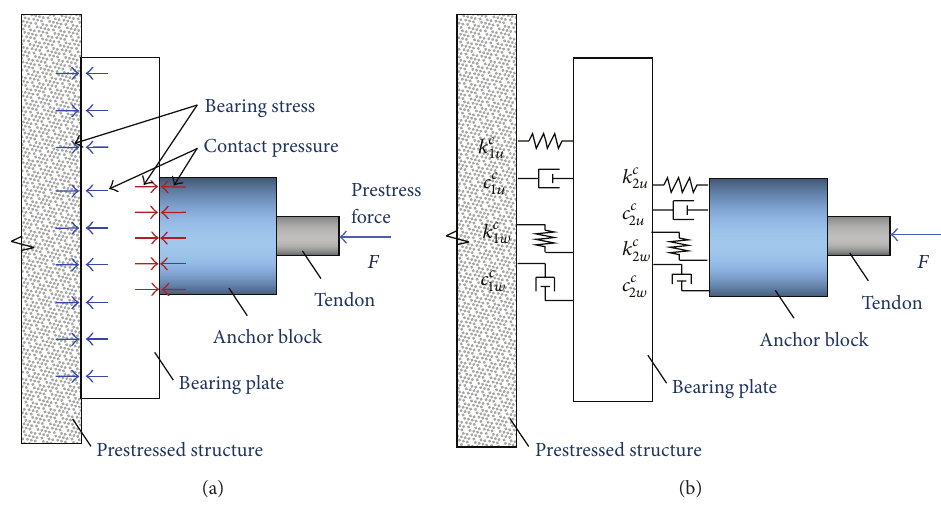
Figure 3: Structural model of tendon-anchorage: (a) force equilibrium and (b) analytical